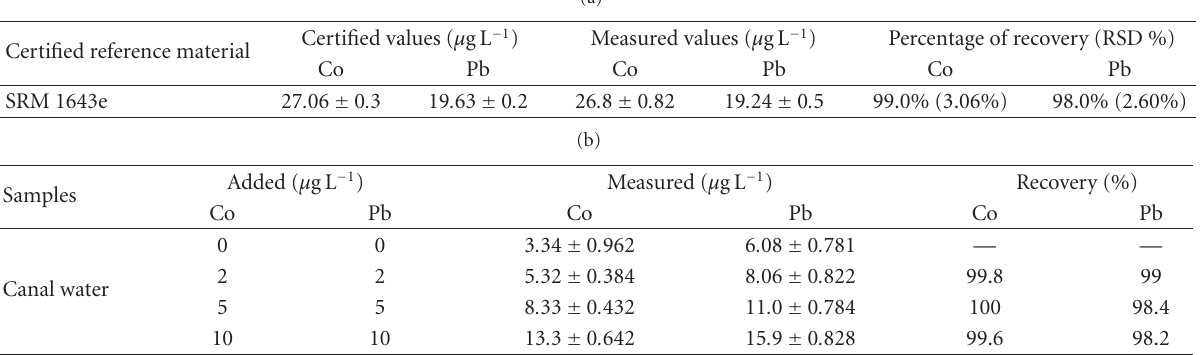
Table 3: Determination of cobalt and lead in certified reference material and water samples.